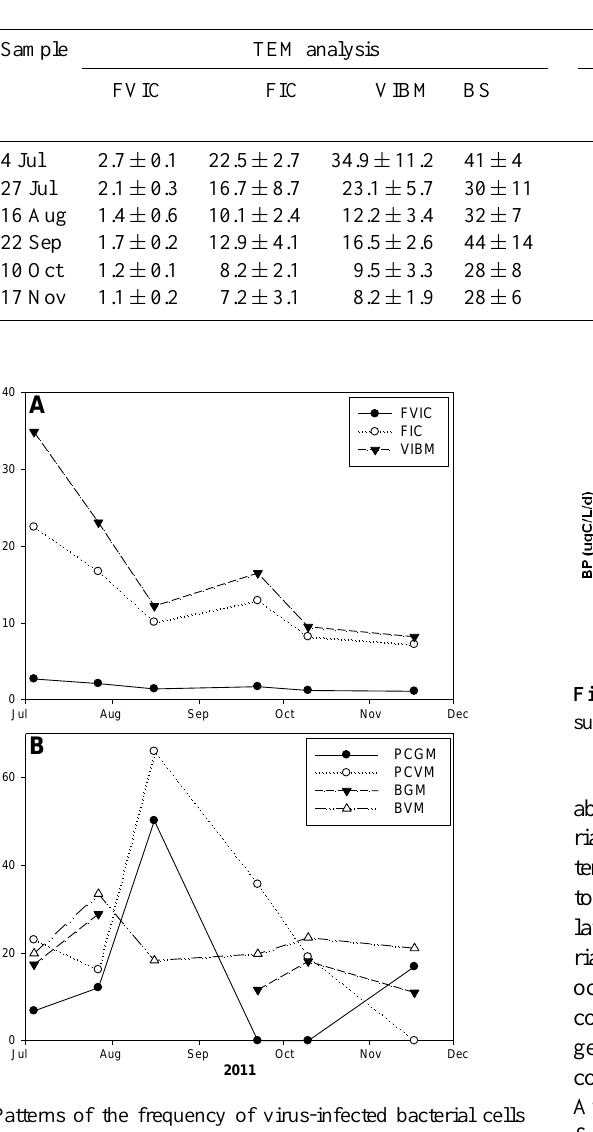
Table 2. Mean values for the frequency of virus-infected cells (FVIC), frequency of infected cells (FIC), virus-induced bacterial mortality (VIBM) and average burst size (BS) as estimated using transmission electron microscopy. PCGM refers to picocyanobacterial mortality due to grazing, while PCVM refers to the virus-mediated mortality of this community. BGM and BVM are as above but for the heterotrophic bacteria.